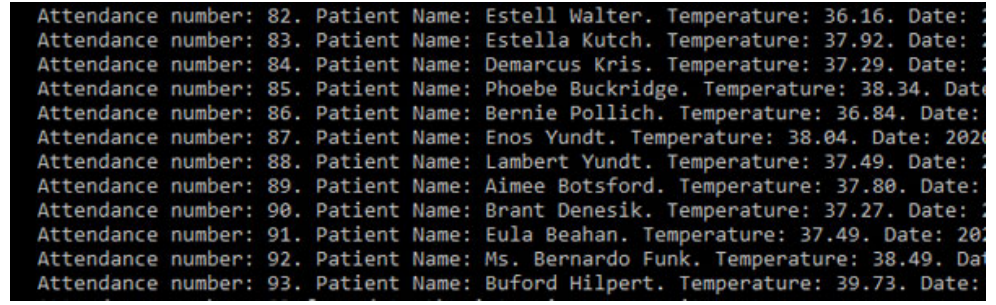
Figure 13. Patient record simulating